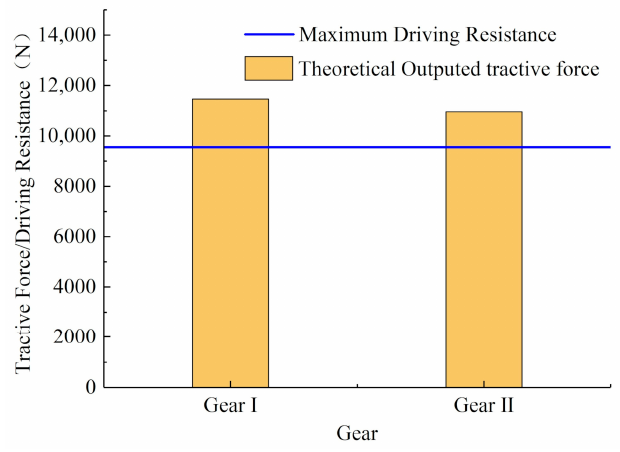
Figure 8. Analysis of the tractive force.